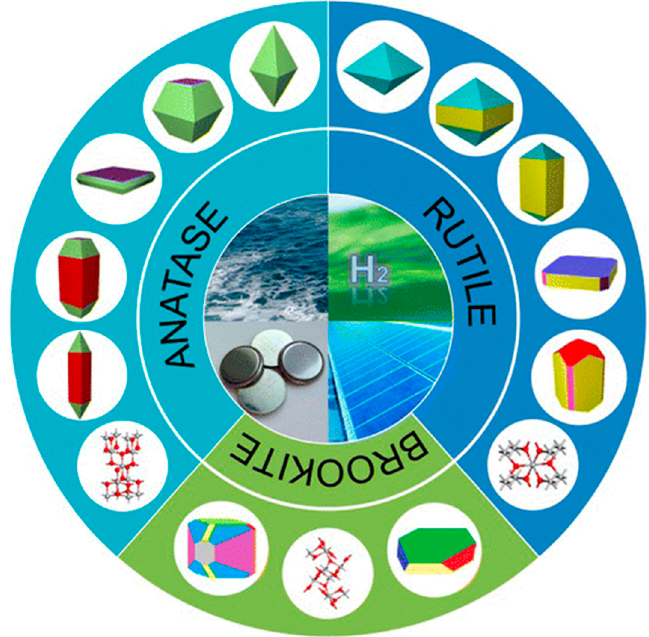
Figure 14. Summary of main shapes and applications (i.e., lithium ion batteries, photocatalytic hydrogen evolution, photodegradation, and solar cells) of anatase, rutile, and brookite TiO 2 crystals with their surfaces consisting of different Facets [89]. Copyright 2014 American Chemical Society.